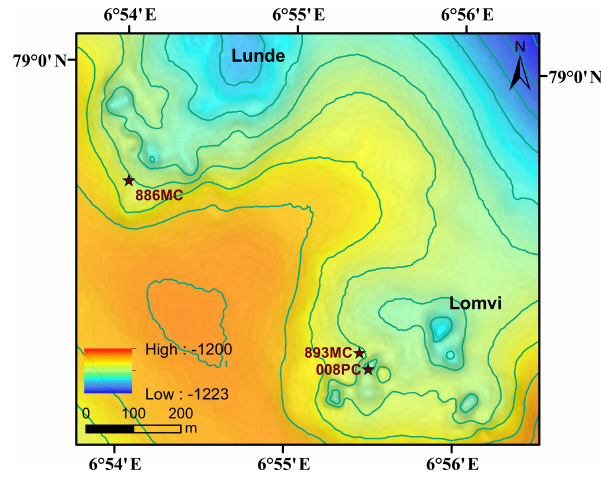
Figure 1. Regional multibeam bathymetric map of Vestnesa Ridge showing the Lunde and Lomvi pockmarks and sampling locations. Locations of multicores and push cores used in this paper are de- noted as